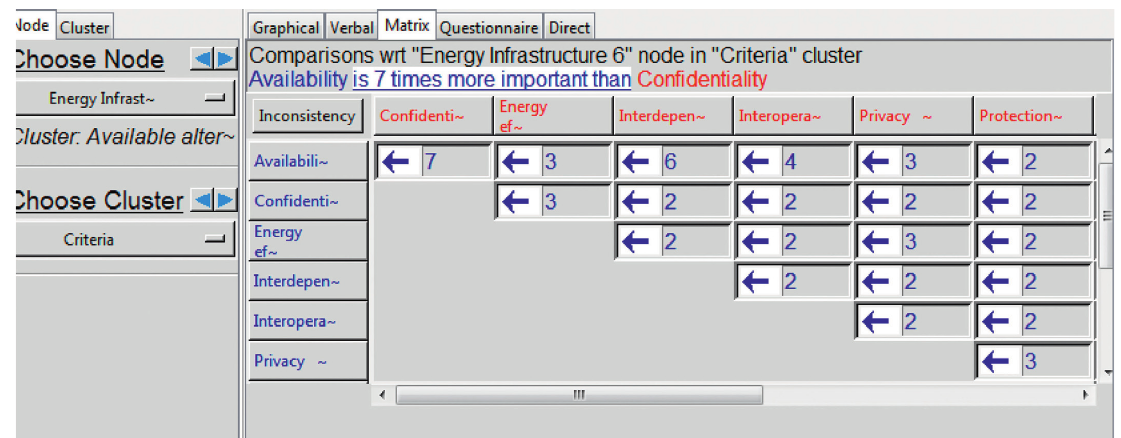
Figure 3: Representation of the node comparison with respect to energy infrastructure.